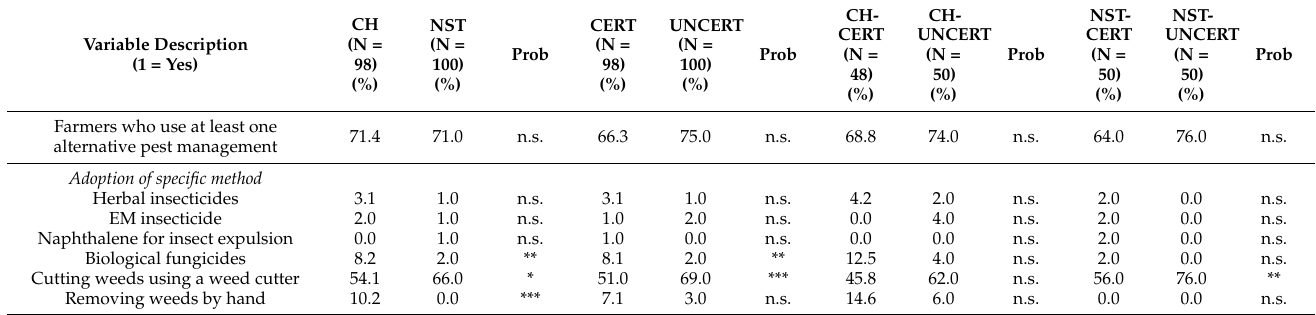
Table 9. Respondent farmers’ adoption of alternative pest management methods by percentage.